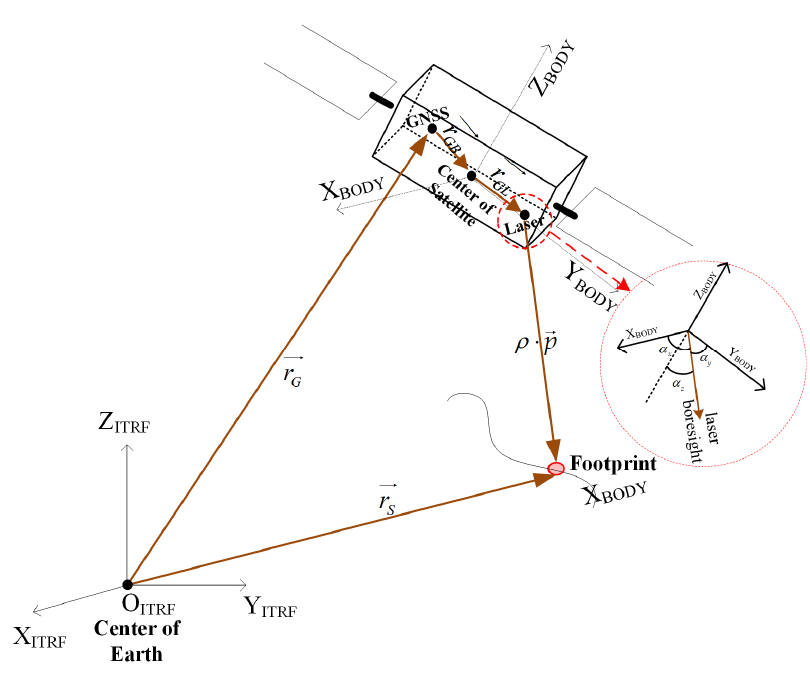
Figure 6. Diagram showing the geometric relationship between the satellite laser and the ground laser